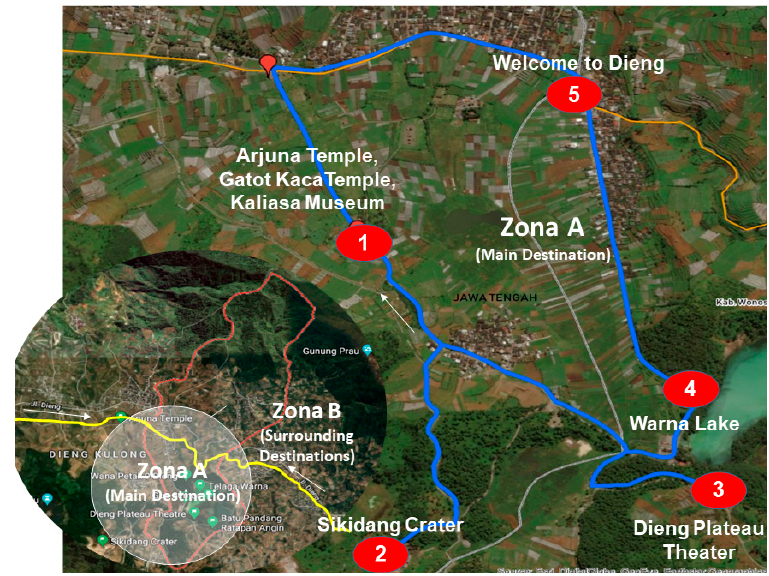
Figure 1. Dieng tourist area map.